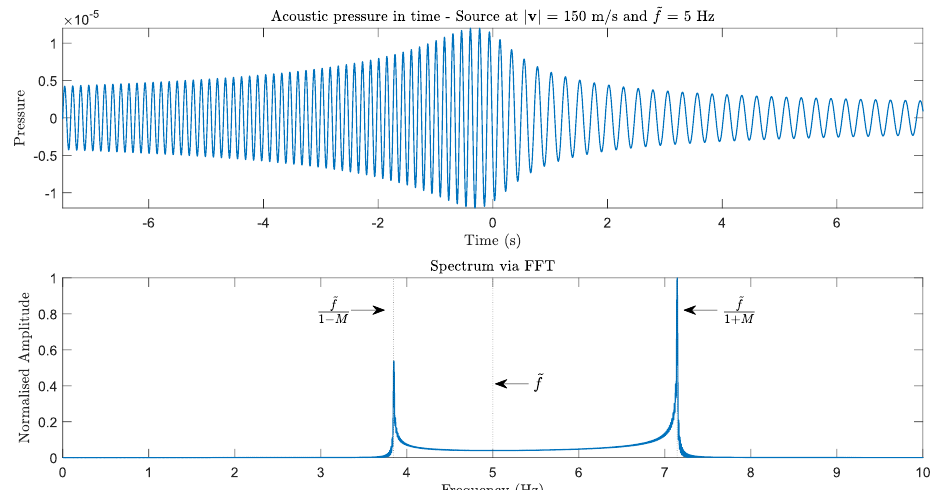
Figure A1. Example of simulated monochromatic wavefield p ˜ ω . Medium speed is c = 500 m/s and medium density is set to ρ = 1. The receiver location is x = ( 0 m,100 m ) . The monochromatic source travels with speed | v | = 150m/s along the positive direction of the x -axis, emitting sound at ˜ f = 5Hz. It crosses the origin at time t = 0 according to our parametrization. For illustration purposes, source parameters were chosen so that the Doppler effect could be plainly appreciated in the waveform (low emitting frequency ˜ f , relatively high value of M at 0.3). The top panel shows the waveform in the time domain directly implemented from Equation (A14). We can see how the perceived frequency increases or decreases when the source is moving towards or away from the receiver, respectively. The bottom panel shows the spectrum of this source, calculated numerically via the fast Fourier transform (FFT) in Matlab. The spectrum spreads between the frequency values ˜ f predicted by the standard Doppler formula, , highlighted in gray dotted 1 ± M